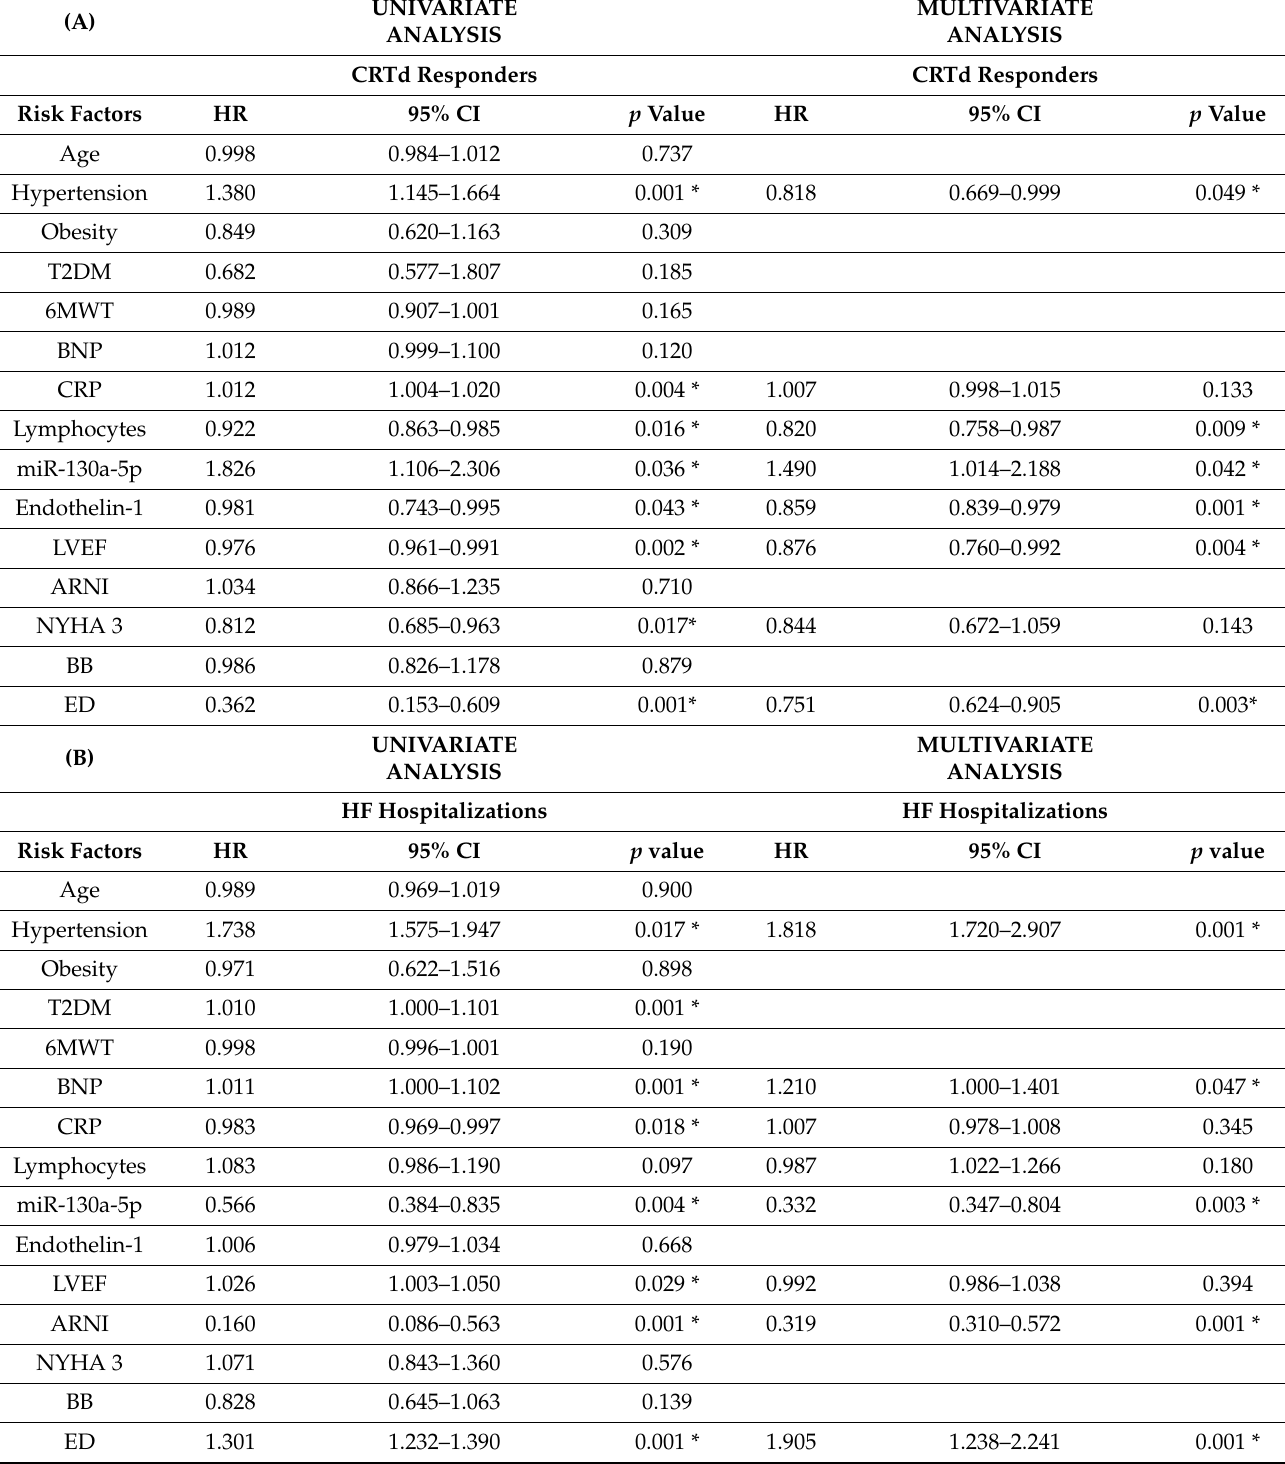
Table 3. Multivariable Cox regression analysis for assessing independent predictors of CRTd